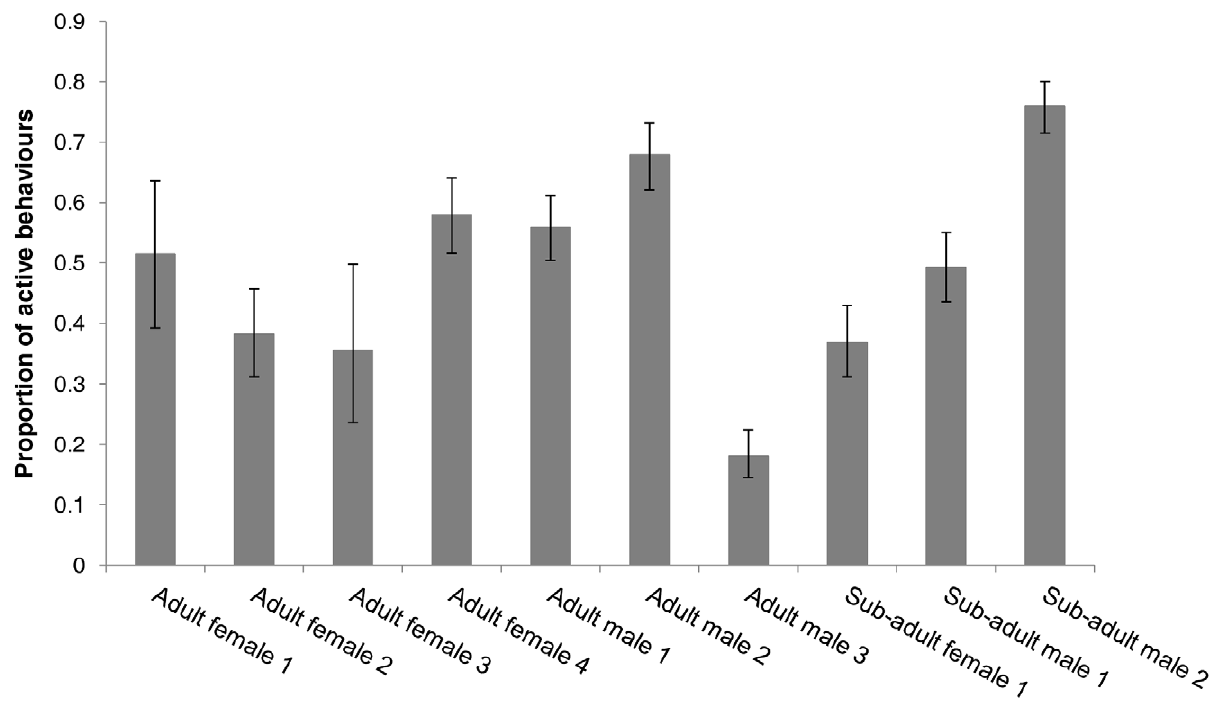
Figure 1. Proportion of active behaviours across individuals in the study. The standard error of the logit values were used to construct 95% confidence intervals indicated by the error bar.